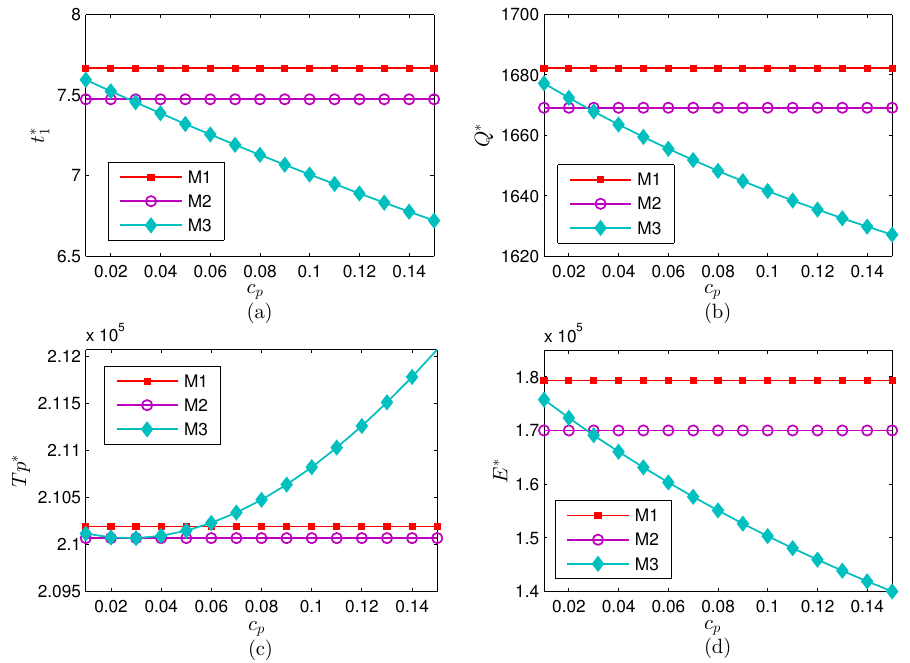
Figure 5. The impacts of carbon price on the optimal inventory performance. ( a ) Comparison of the optimal time point with carbon price. ( b ) Comparison of the optimal order quantity with carbon price. ( c ) Comparison of the optimal total profit with carbon price. ( d ) Comparison of the optimal total carbon emissions with carbon